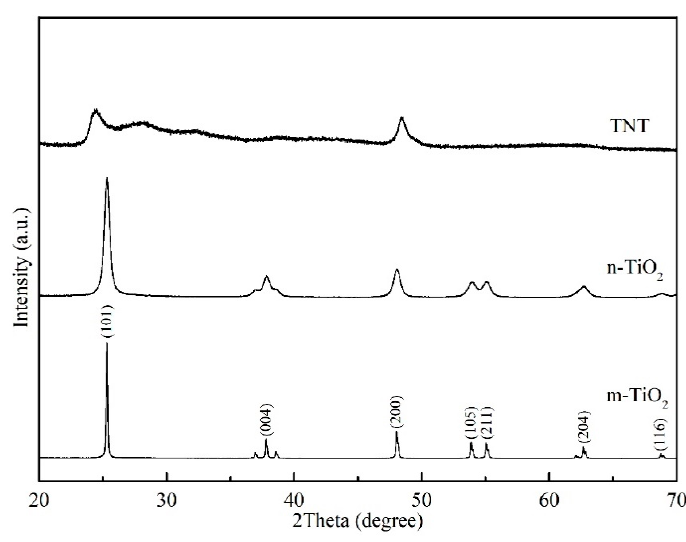
Figure 4. Comparison of the XRD patterns of m-TiO 2 , n-TiO 2 , and TNT.